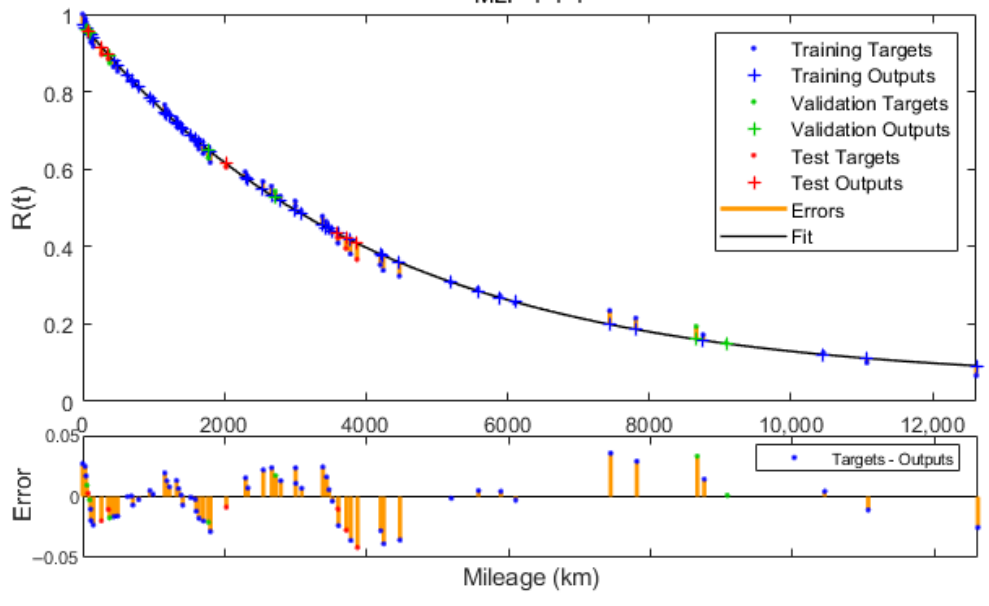
Figure 9. Reliability function approximated by MLP 1-1-1.